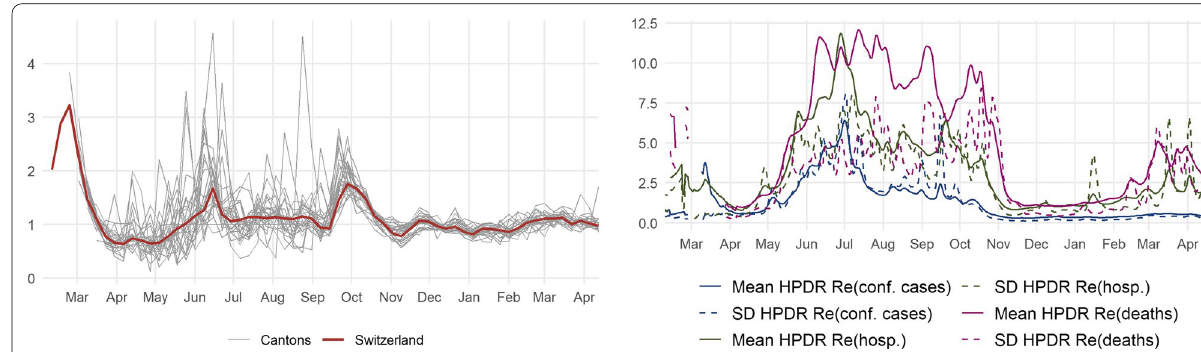
Fig. 4 Effective reproduction number R e and estimation uncertainty. The effective reproduction number R e (left panel) is estimated by Huisman et al. (2020) using the EpiEstim method by Cori et al. (2013). The right panel shows the uncertainty associated with the estimation of R e based on confirmed cases, hospitalizations and deaths. The solid (dashed) lines represent the daily mean (standard deviation) of the highest posterior density range (HPDR) across